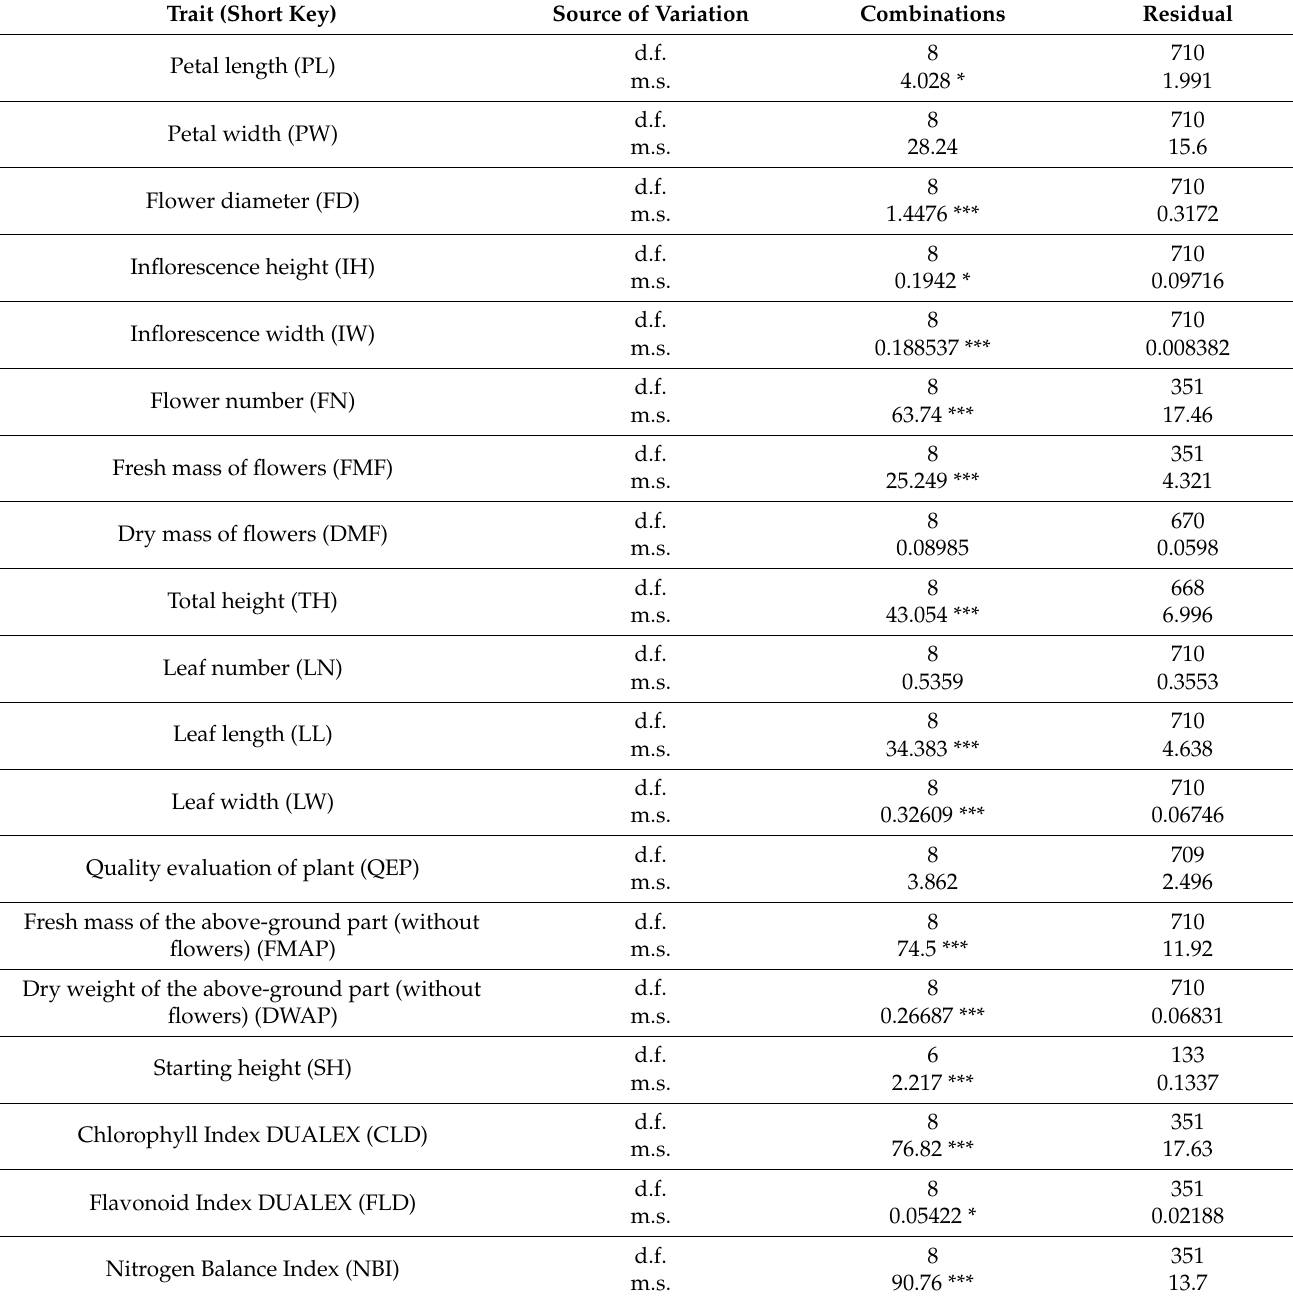
Table 4. Mean squares (m.s.) from one-way analysis of variance for observed